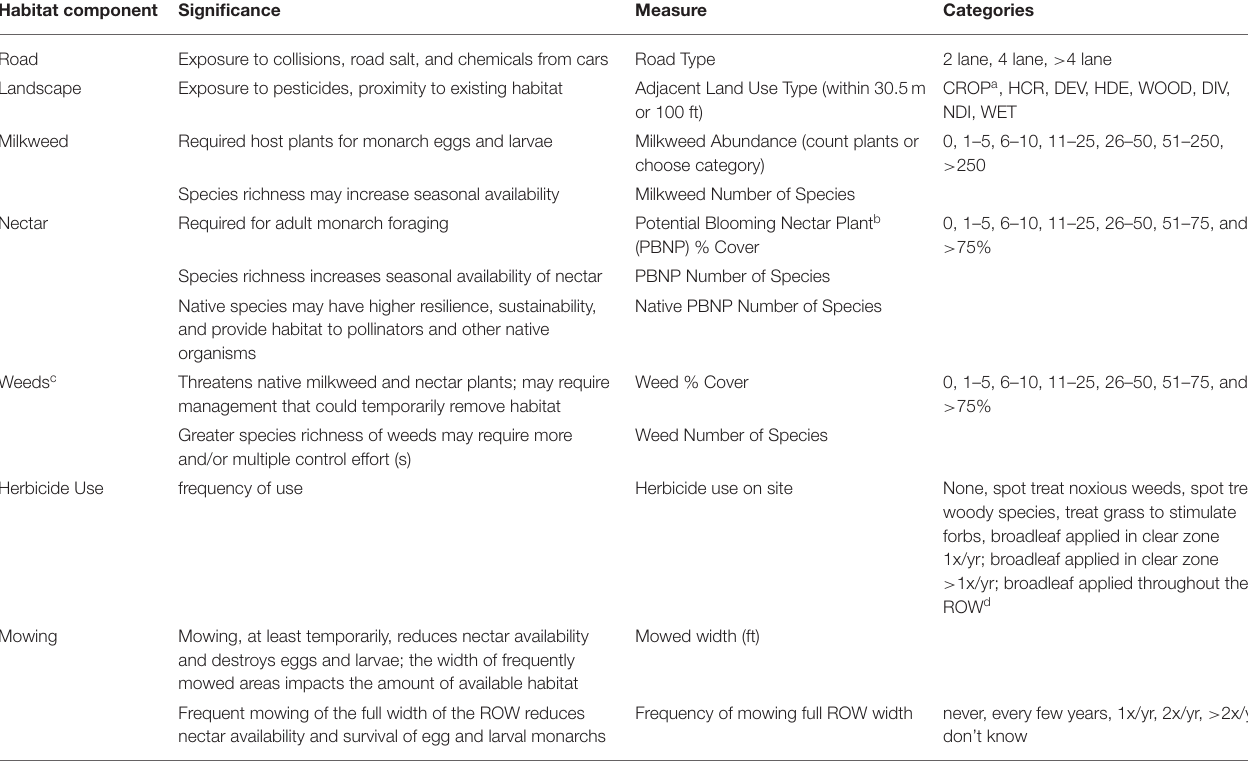
TABLE 1 | Habitat components (and data collected) for roadside right-of-way habitats using the Rapid Assessment. Habitat component